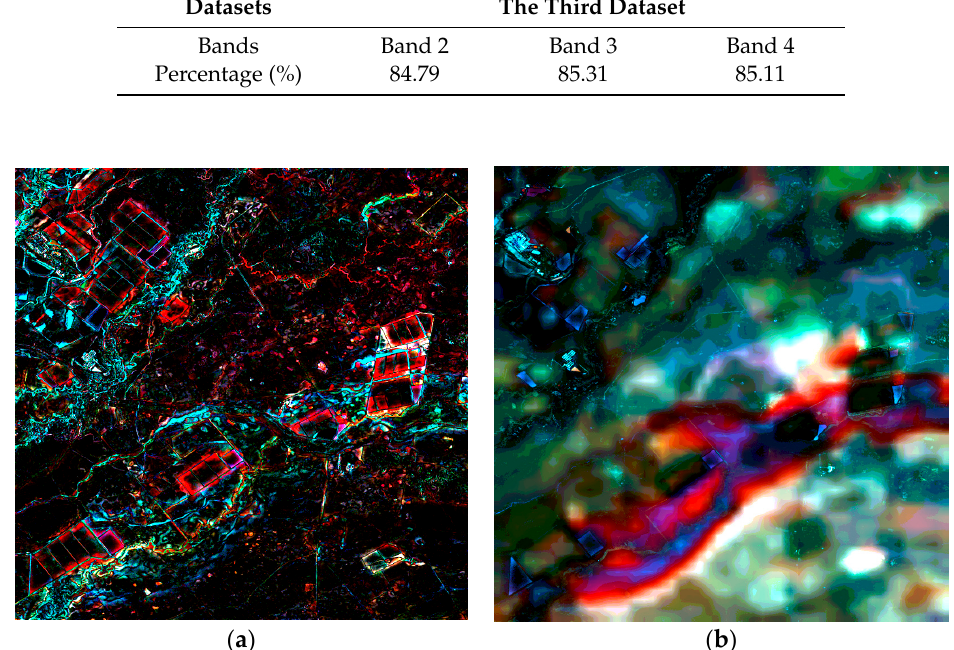
Figure 10. NIR-red-green composites of the squared error (with max values for bands NIR, red and green are 0.0025, 0.0011, and 0.0007) ( a ) and estimation variance (with max values for bands NIR, red and green are 0.0013, 0.0011 and 0.0008); ( b ) results for the third dataset.